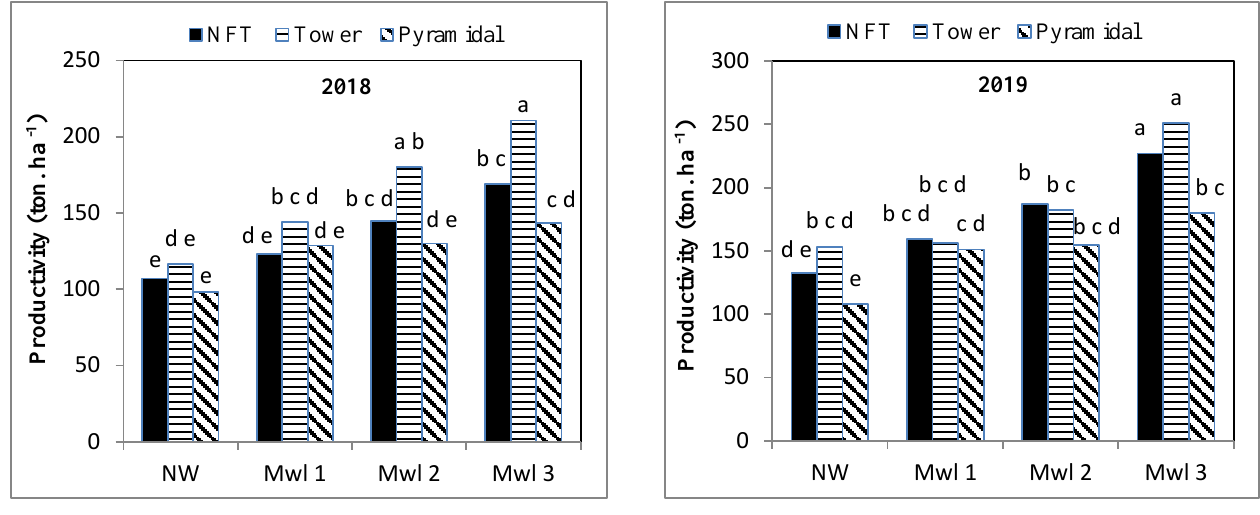
Figure 5. Strawberry productivity of different soilless culture systems under normal and magnetic water. Lowercase letters a – e are homogeneous groups; means followed by the same letters are not significantly different from one another based on Duncan’s protected LSD test ( p ≤ 0.05 ).